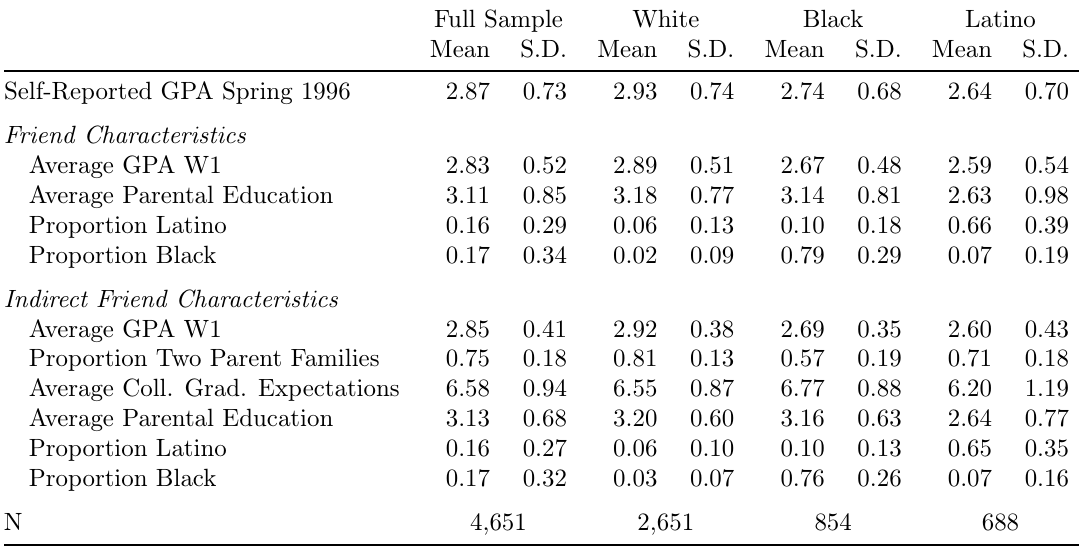
Table 1: Means and standard deviations of individual GPA, friends’ characteristics, and indirect friends’ characteristics, Add